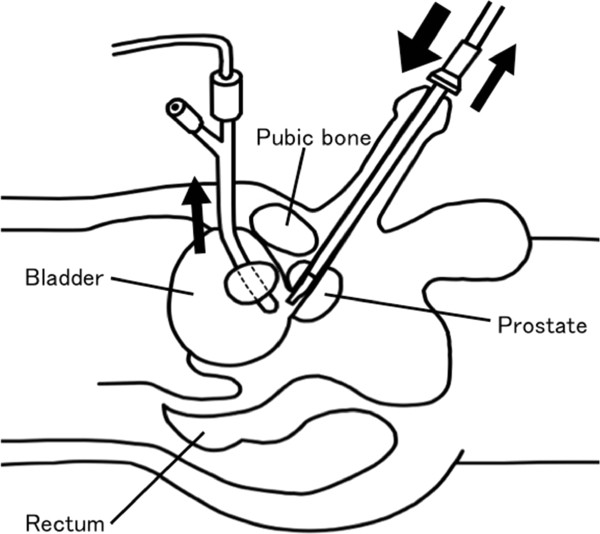
Continuous irrigation fluid drainage through suprapubic cystostomy. A catheter of the irrigation fluid drainage was inserted preoperatively under spinal anesthesia. Arrows demonstrate flows of the irrigation fluid.